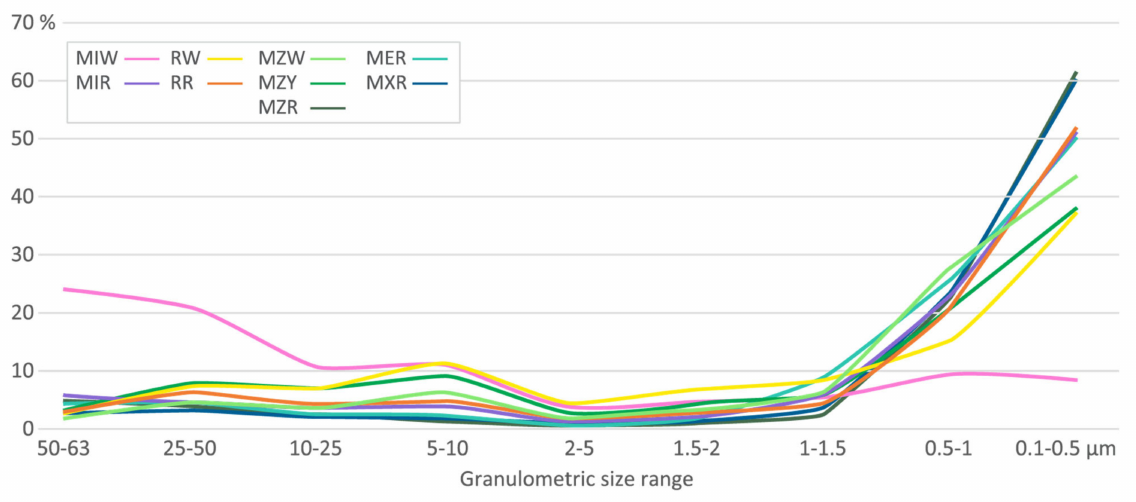
Figure 5. Relative granulometric distribution of silt fraction particles (in